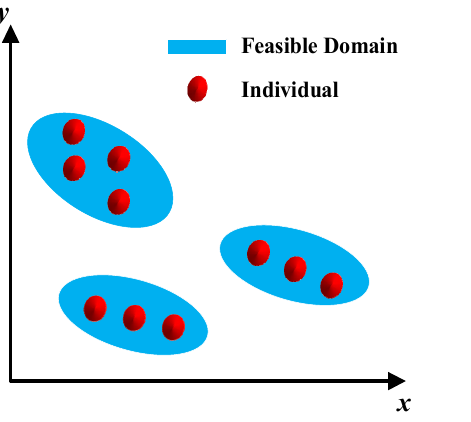
Figure 10. Area division diagram.